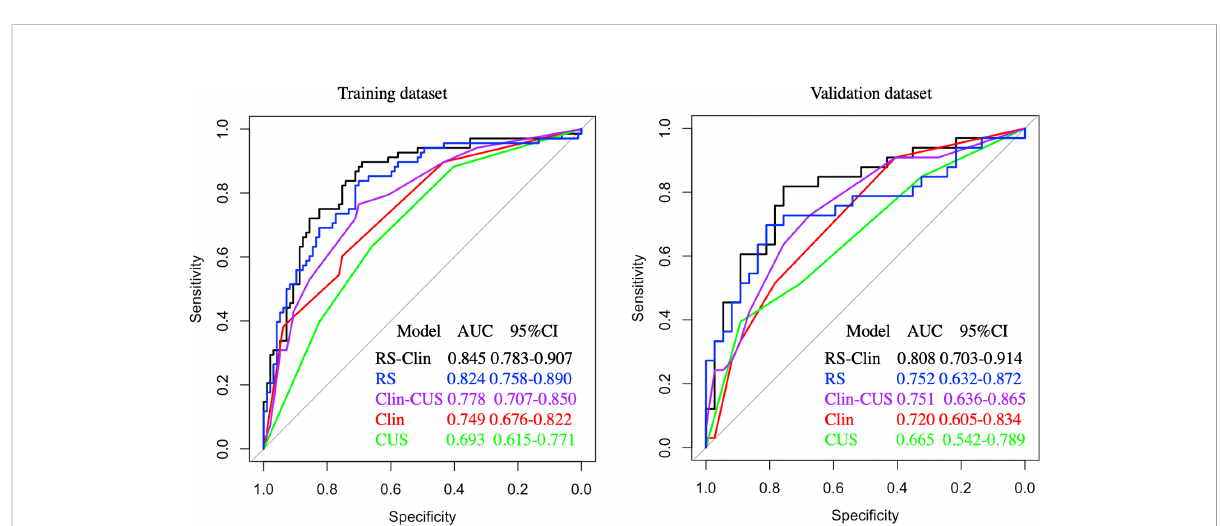
FIGURE 4 Receiver operating characteristic curves of different predictive models for predicting CLNM in training and validation dataset. CLNM, central lymph node metastasis; Clin-RS, clinical data + radiomics scores; RS, radiomics scores; Clin-CUS, clinical data + conventional ultrasound; Clin, clinical data; CUS, conventional ultrasound.